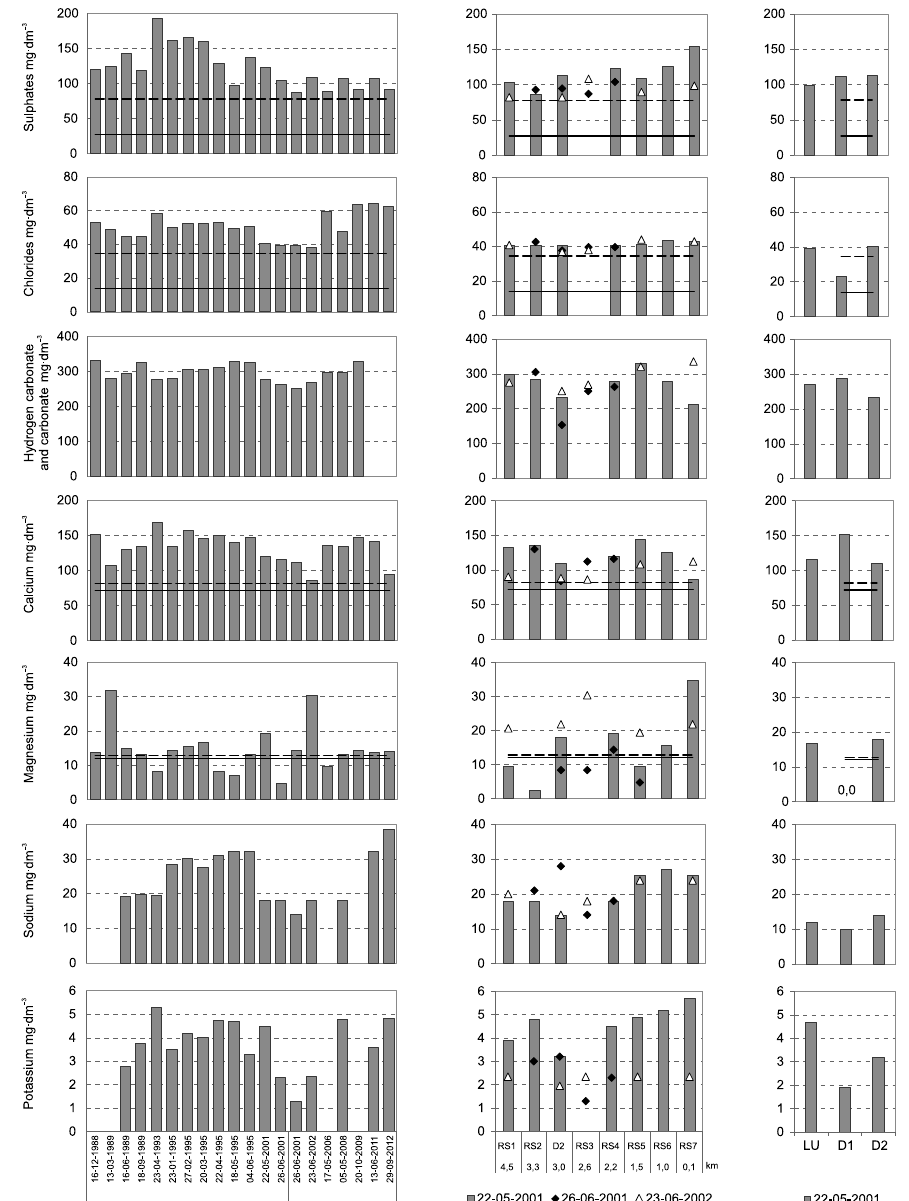
Fig. 10. Major ions: sulphates, chlorides, hydrogen carbonate with carbonate, calcium, magnesium, sodium and